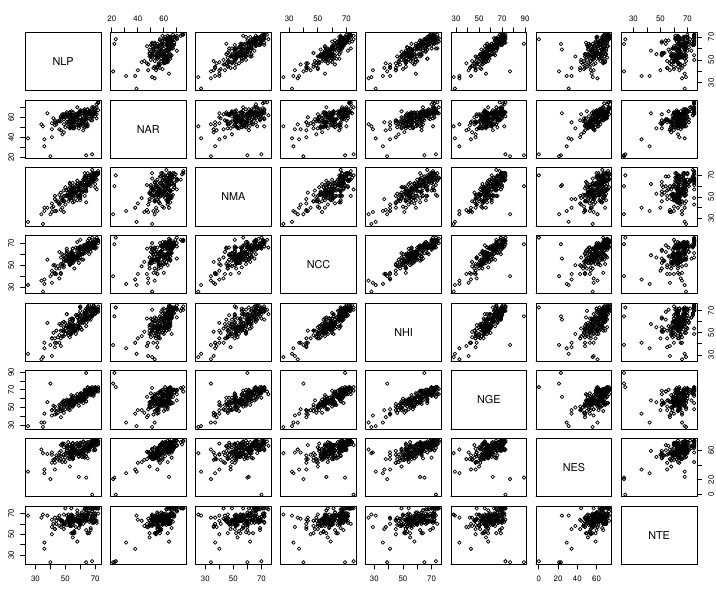
Figure 7. Correlations between disciplines and the associated grades. The disciplines’ grades are Portuguese language (NLP), Arts (NAR), Math (NMA), Science (NCC), History (NHI), Geography (NGE), Spanish (NES) and Technology